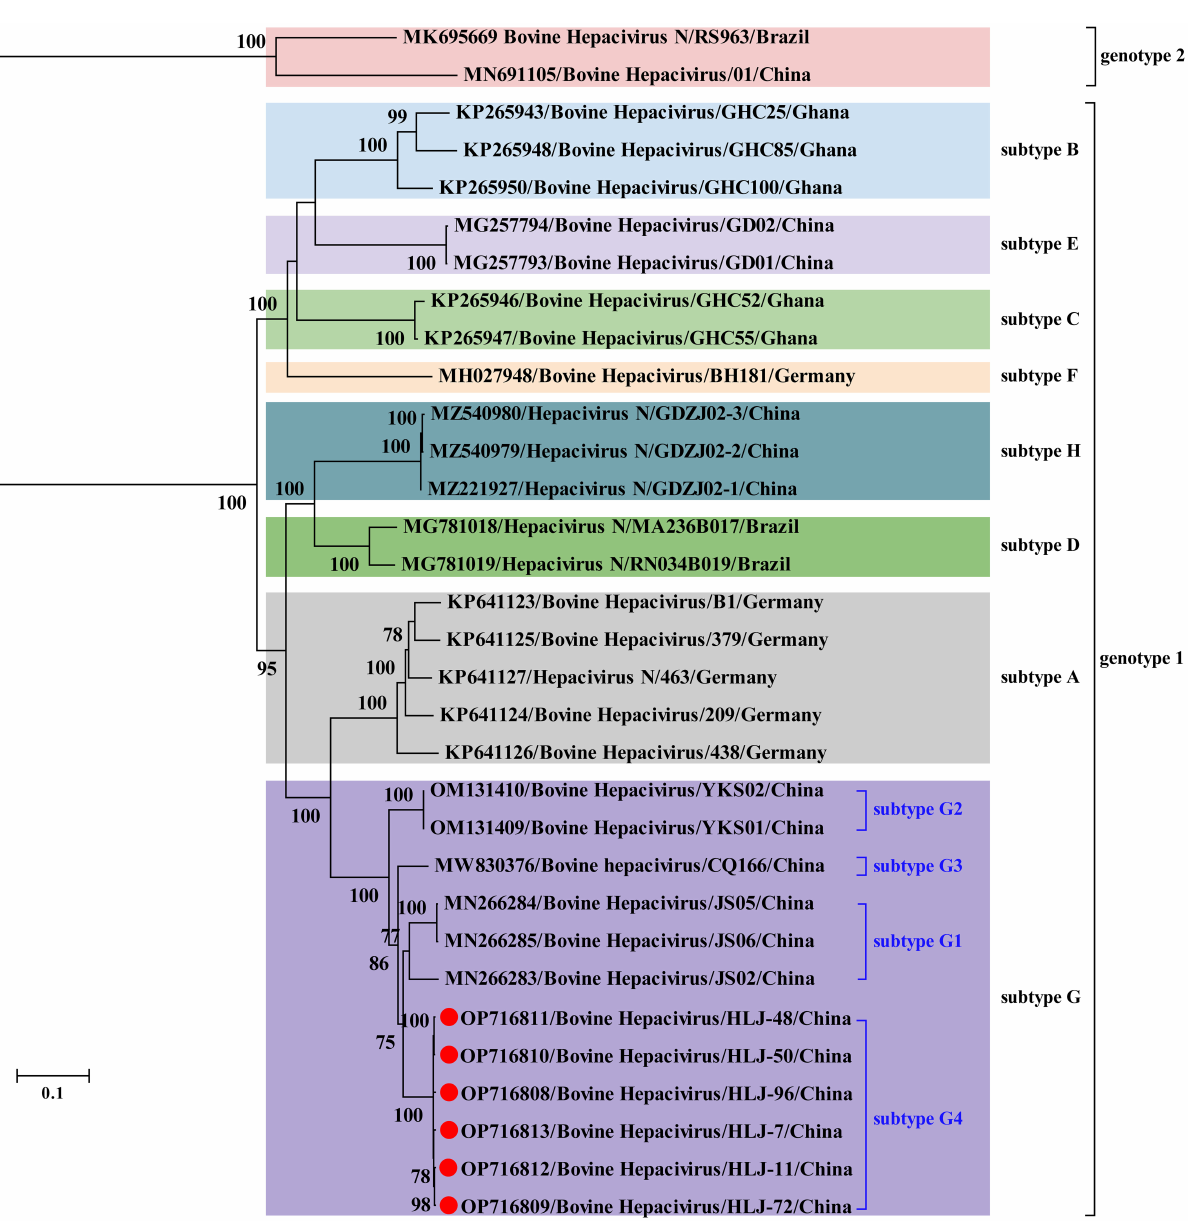
FIGURE2 Phylogenetic analysis based on the nucleotide sequences of complete polyprotein-coding region of BovHepV including the newly identified sequences and other reference sequences retrieved from GenBank. The trees were constructed based on the maximum likelihood method implemented in MEGA 7.0, and mid-point rooted for clarity and the scale bar represents the number of nucleotide substitutions per site. Bootstrap values were calculated with 100 replicates of the alignment, and only bootstrap values > 70% are shown at relevant nodes. GenBank accession numbers are followed by the name of hepacivirus strains. Red dots indicate the BovHepV determined in this